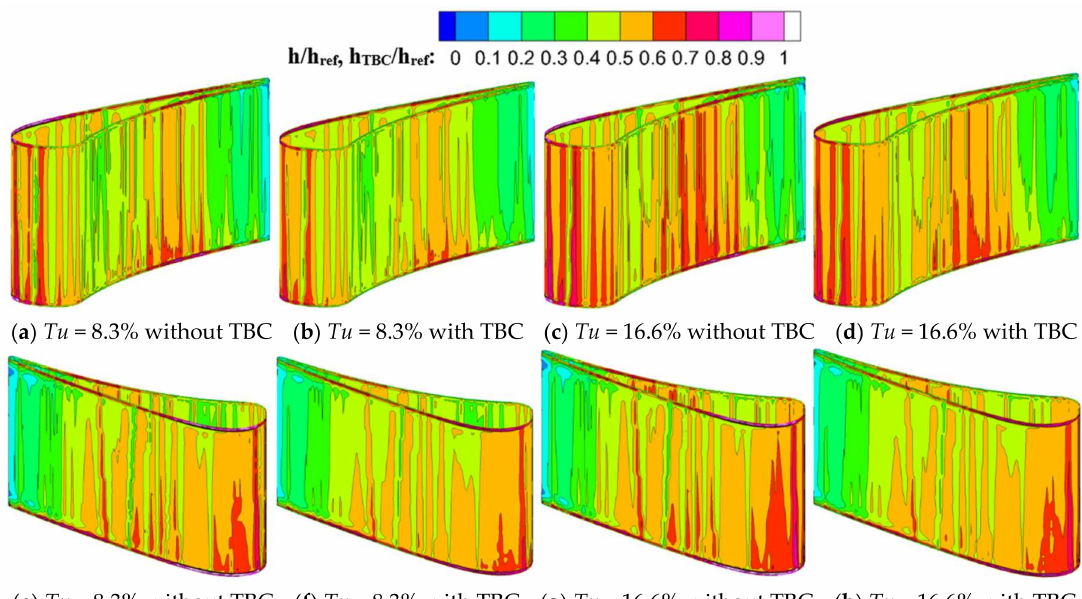
Figure 13. Contours of h and h TBC at Tu = 8.3% and